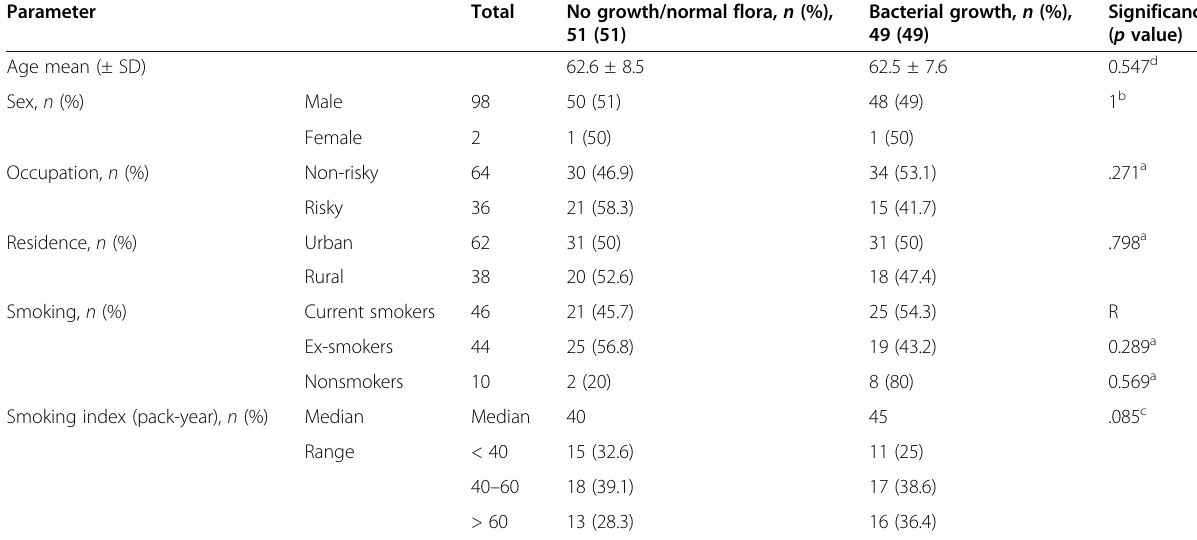
Table 5 Bacterial isolates in association to clinical and radiological data of studied cases Parameter Total No growth/normal flora,